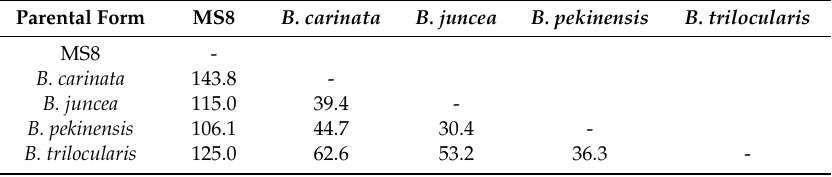
Table 4. Mahalanobis distances for parental forms.